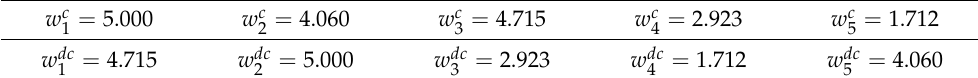
Table 6. Priorities of plans in two